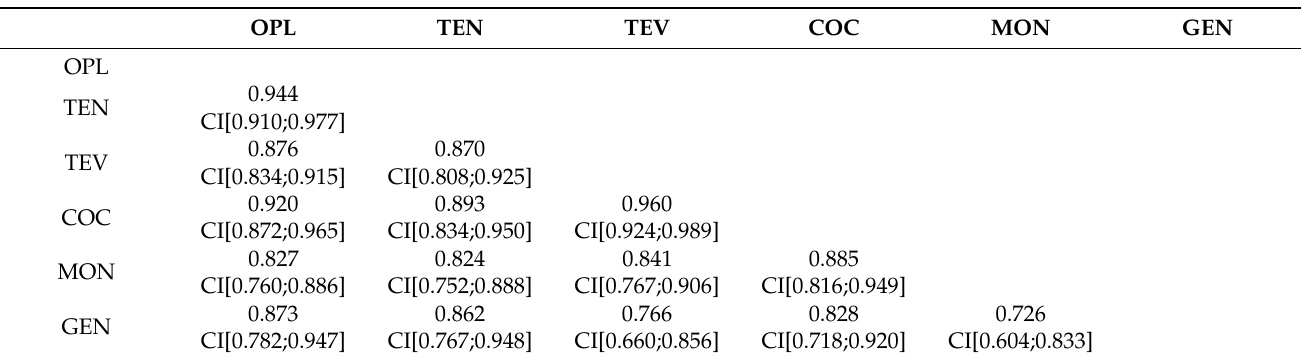
Table 5. HTMT criterion for discriminant validity.